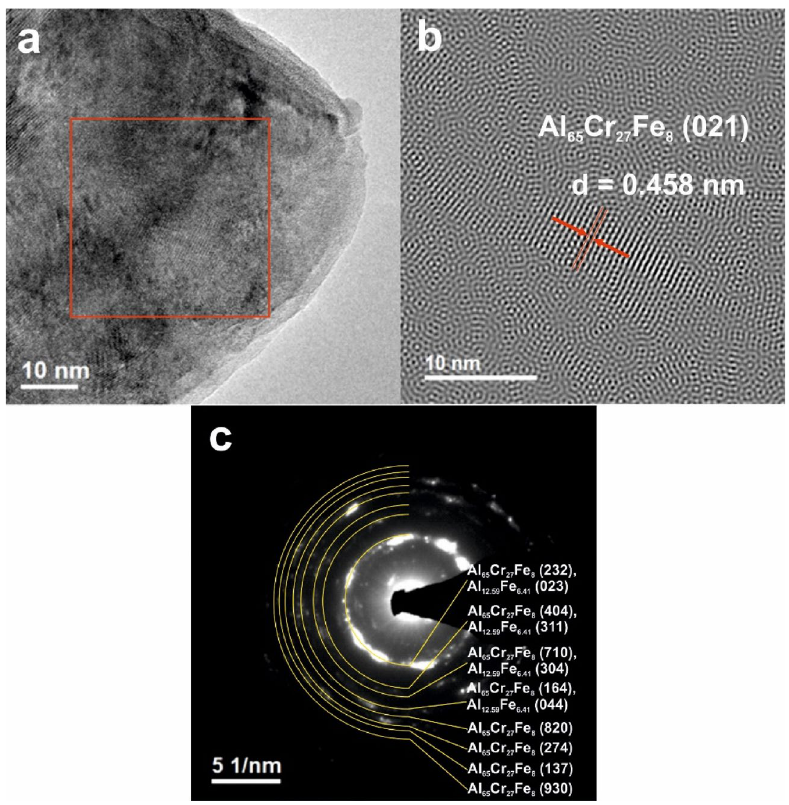
Figure 4. HRTEM image ( a ), IFT image ( b ) and SAED patterns ( c ) of Al 65 Cr 20 Fe 15